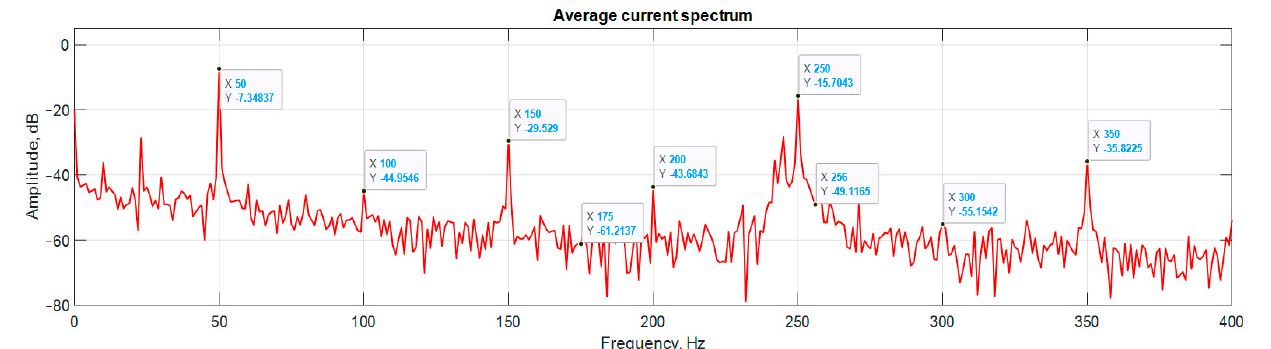
Figure 13. The spectrum at medium defect.